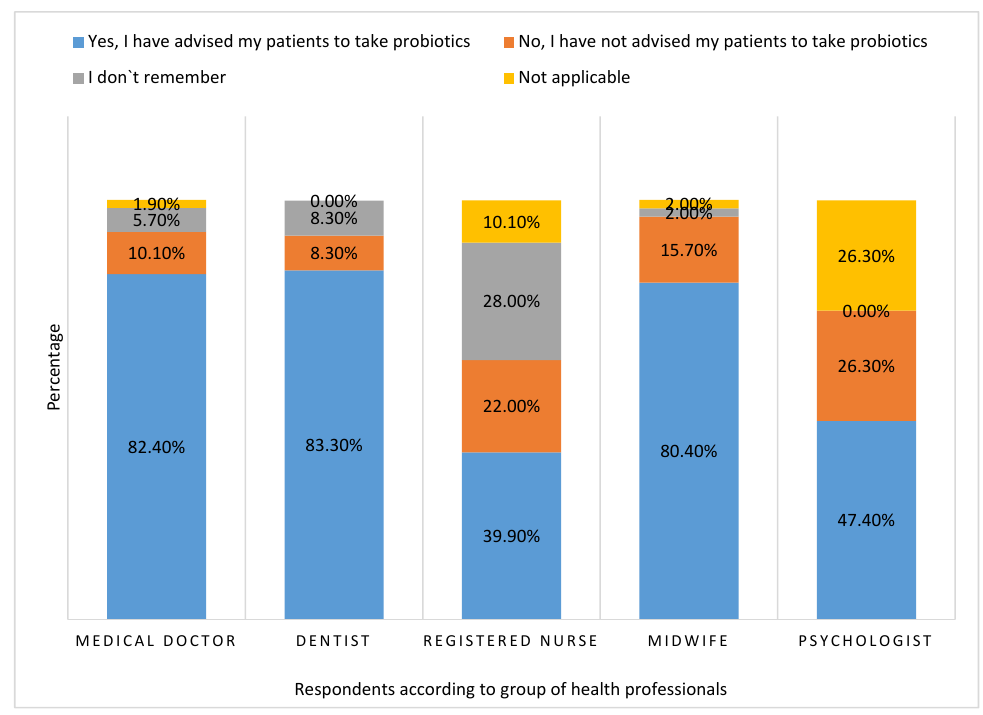
Figure 6. Advice regarding the use of probiotics to patients by profession.